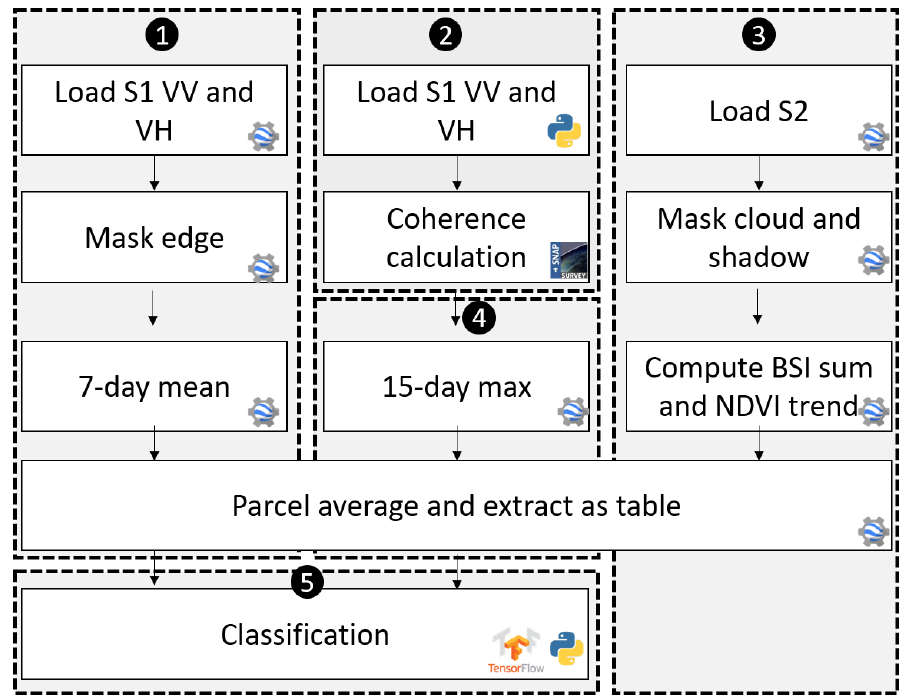
Figure A1. Codes developed in this study are open and available to the public. They are divided into five chunks using different formats and libraries including JavaScript for GEE, Python, SNAP and TensorFlow.